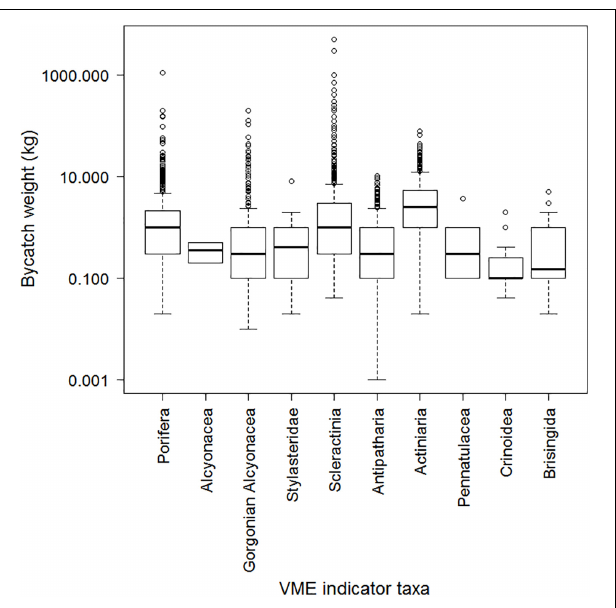
FIGURE 4 | Bycatch weight (kg) of VME indicator taxa in New Zealand bottom trawls within the SPRFMO Convention Area as reported by observers for the 2008–2018 period. Within each boxplot the line indicates the 50th percentile (median), the box encompasses 50% of the data, from the 25th to the 75th percentile and the dashed vertical lines extend to 1.5 times the interquartile range, with circles indicating “outliers.” Note that the y -axis is plotted on a